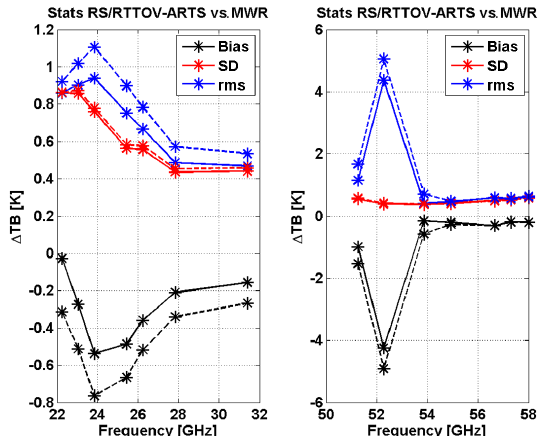
Figure 6. Bias (black line), standard deviation (red line), and rms (blue line) of differences between TB measured with the microwave radiometer and TB simulated from radiosonde profiles respectively with RTTOV-gb (solid lines) and the reference radiative transfer model ARTS (dashed lines), both for clear-sky conditions at 90 ◦ elevation angle (measurements minus